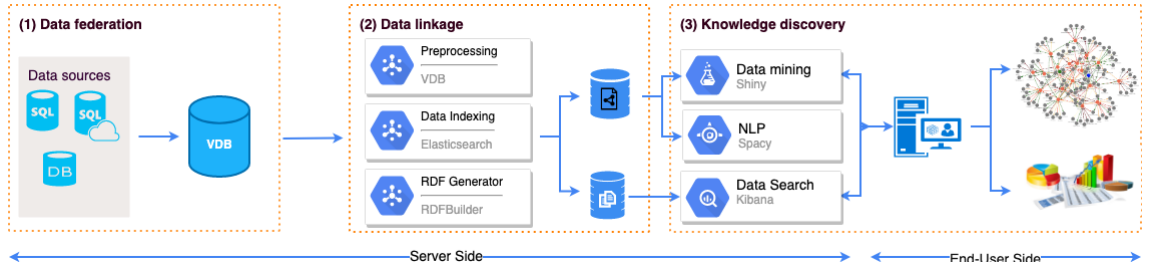
Figure 1. Overview of system architecture: (1) Data Federation , (2) Data Linkage , and (3) Knowledge Discovery